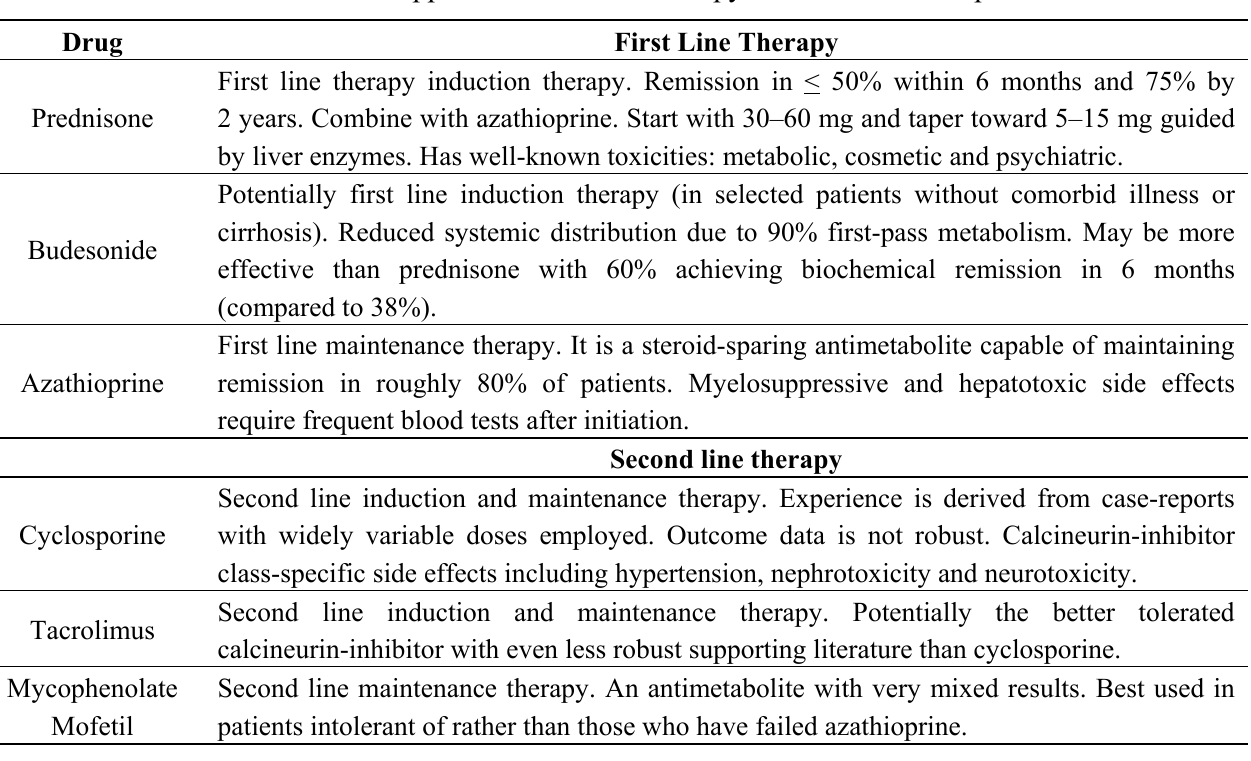
Table 1. Immunosuppressive Pharmacotherapy—Autoimmune